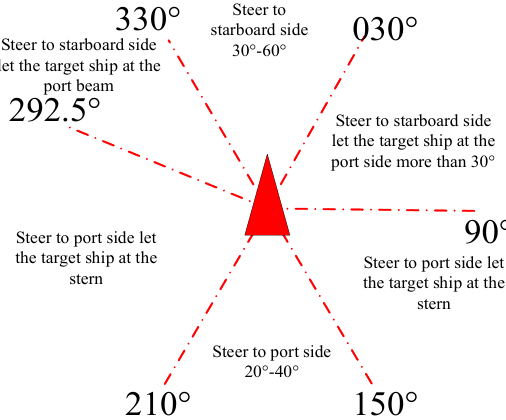
Figure 2. Radar-based collision avoidance steering